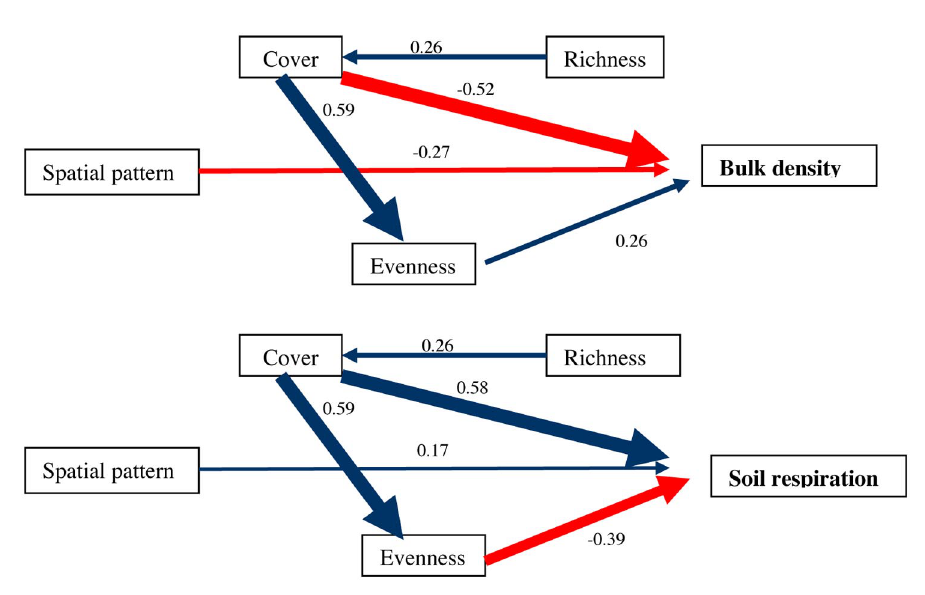
Fig. 5. Structural model showing the relationships between the attributes of biological soil crusts and different surrogates of ecosystem functioning in a gypsum area from Alicante (SE Spain). Only significant paths are shown. The breadth of the arrow is proportional to the standardized path coefficient, which is indicated by the corresponding number. Positive and negative relationships are in blue and red, respectively. Adapted from Maestre et al.